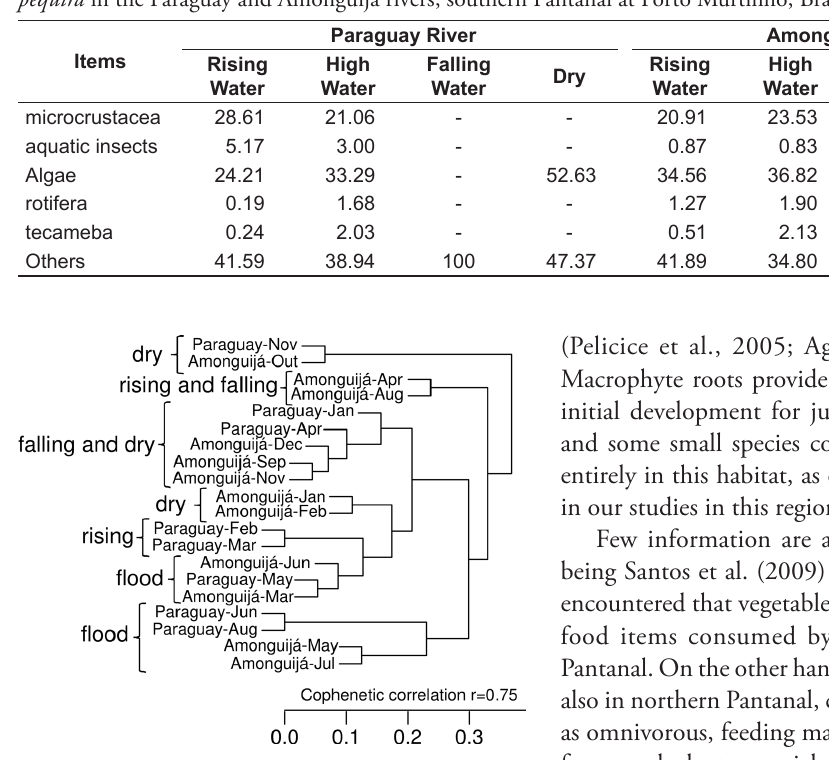
Figure 3. Similarity dendrogram (Bray-curtis coefficient) of dietary composition (Alimentary index) of Odontostilbe pequira in the Paraguay and Amonguijá rivers, southern Pantanal at Porto Murtinho, MS,